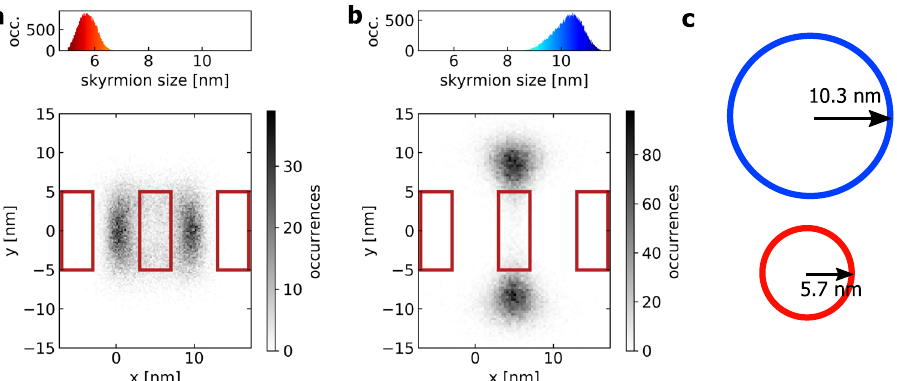
Fig. 5 Skyrmion boundary pinning simulation. Histograms of occurring skyrmion center positions for external out-of-plane fi elds of ( a ) 0.15 T and ( b ) 0.05 T based on micromagnetic simulations. The greyscale represents the number of skyrmion center occurrences at a position. Red boxes indicate the area where the magnetic anisotropy is reduced. The top histograms show the skyrmion size distribution. c Size comparison of the average sizes from ( a ) and ( b ). The scaling is identical for ( a – c